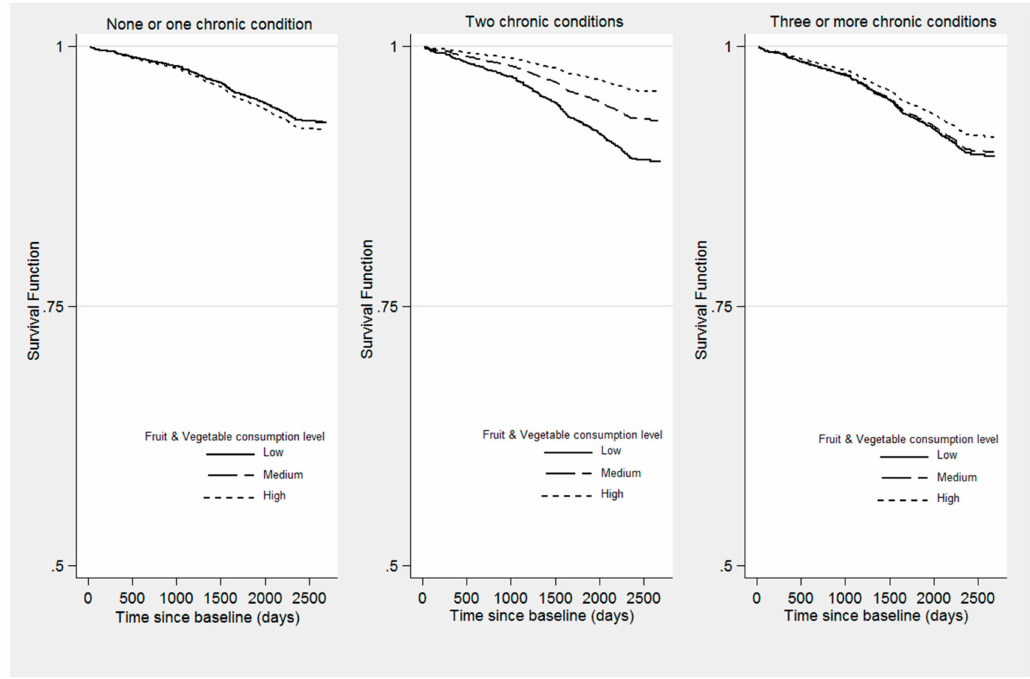
Figure 2. Survival function according to the level of fruit and vegetable consumption and number of chronic conditions ( n = 1699). The first subfigure (left) shows the survival curves according to the three levels of fruit and vegetable intake for people with none or one chronic condition, the second (middle) for those with two chronic conditions and the third (right) shows survival curves associated with fruit and vegetable consumption for respondents with three or more chronic conditions. Note: Survival functions calculated from the adjusted Cox proportional hazards model presented in Table